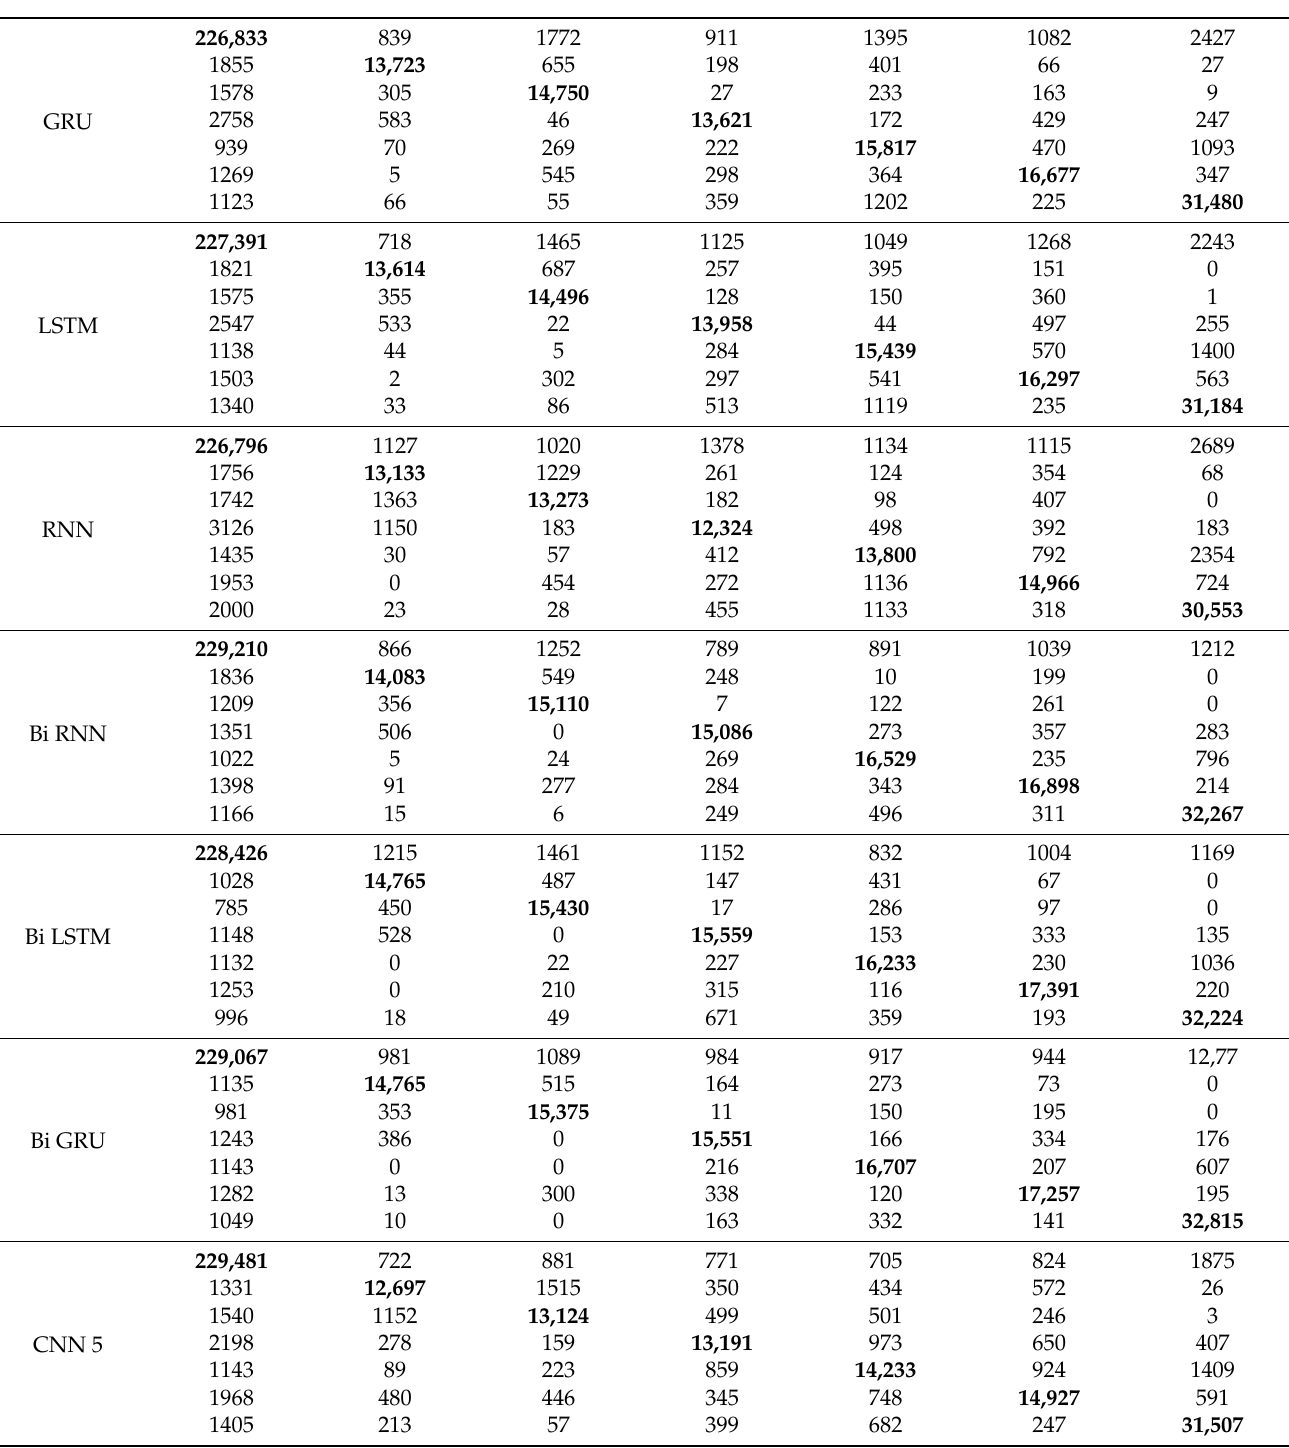
Table A1. Confusion matrix of comparison with other DL models for evaluating performance